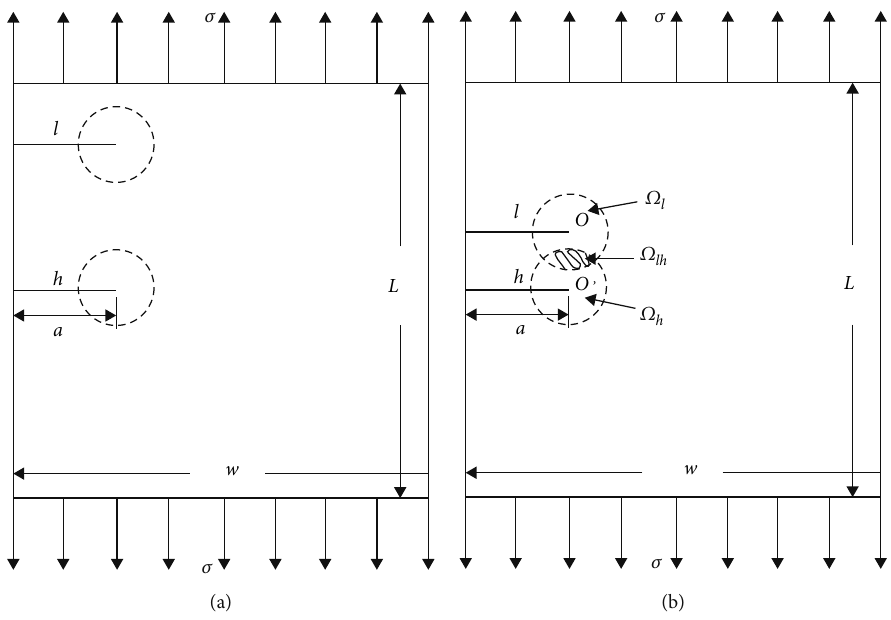
Figure 7: Schematic of the two-crack example: (a) case 1; (b) case